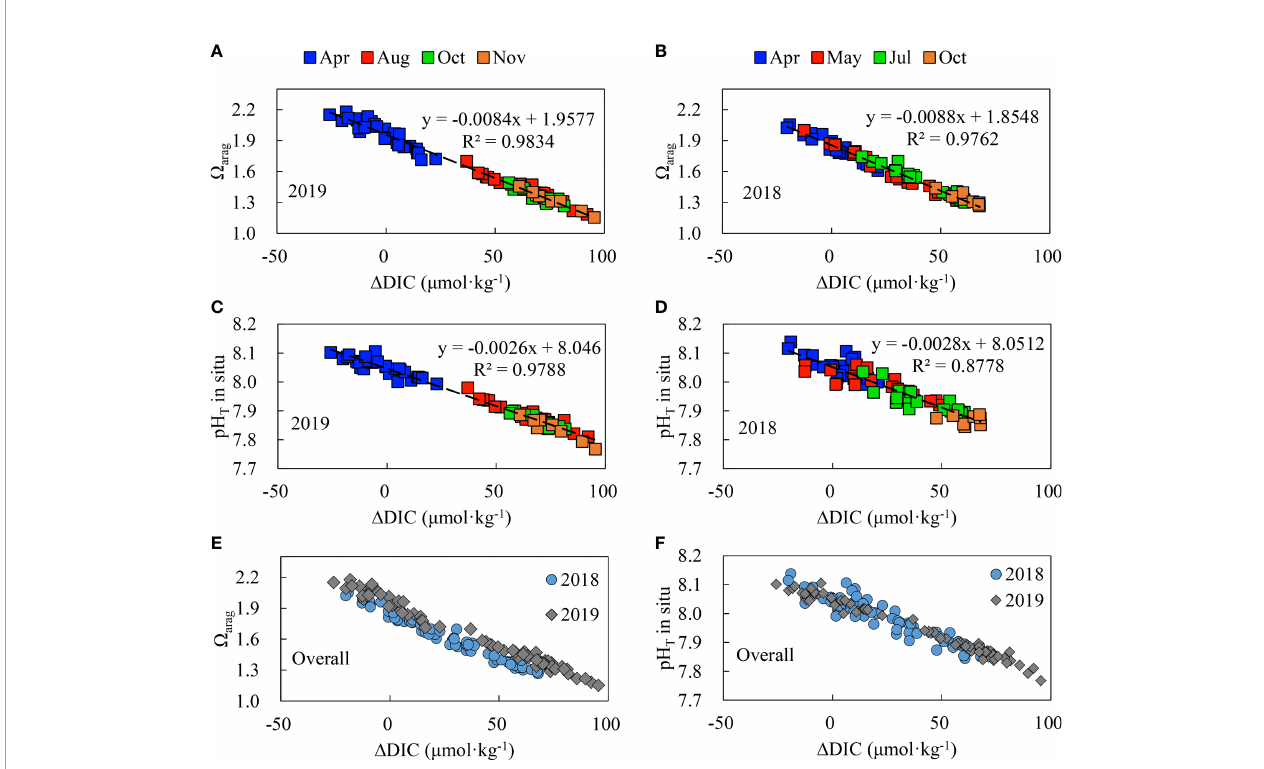
FIGURE 12 | Relationship between W arag and D DIC (A, B) and between pH T and D DIC (C, D) and systematic comparisons of W arag and pH T values (E, F) for 2018 and 2019 in bottom waters of the SYSCYM. D DIC means non-conservative addition (positive values) and/or removal (negative values) [see Equation